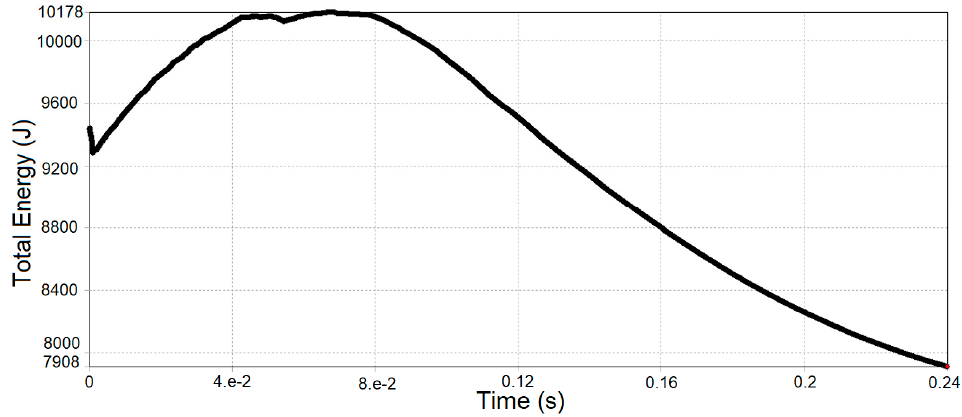
Figure 15. Variation of the total energy of the bus safety frame over time, J.